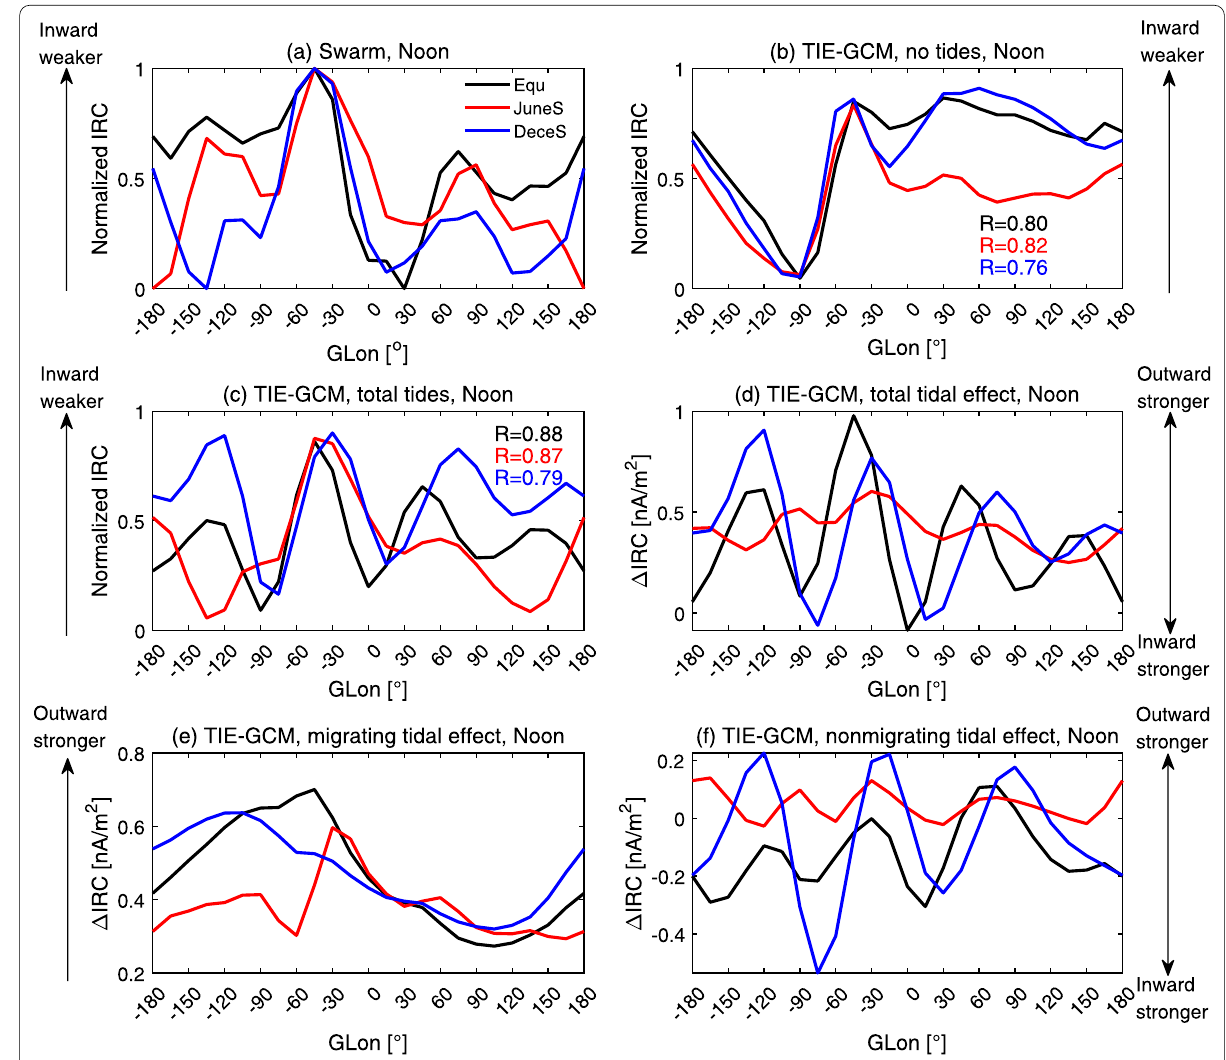
Fig. 3 Longitudinal distribution of the normalized IRC around noon as observed by Swarm satellites ( a ). b TIE–GCM-simulated IRC without tidal input. c TIE–GCM IRC with total tidal inputs. d – f Residual IRC induced by d total tides, e migrating tides, and f nonmigrating tides, respectively. Black, red, and blue curves denote the equinox, JS, and DS, respectively. Larger normalized IRC in ( a – c ) represent weaker inward currents. Positive values in ( d – f ) represent outward currents. The correlation coefficients between model outputs and observations are given for each season. Arrows (double arrows) represent the direction in which the inward or outward current becomes stronger or